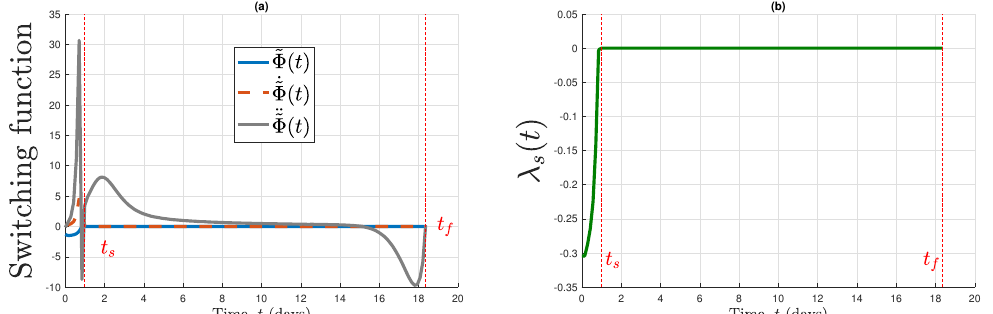
Figure 8. Characterization of the switching instant and of the singular arc in Example 2. ( a ) The switching function and its derivatives. ( b ) The co-state of the substrate s .